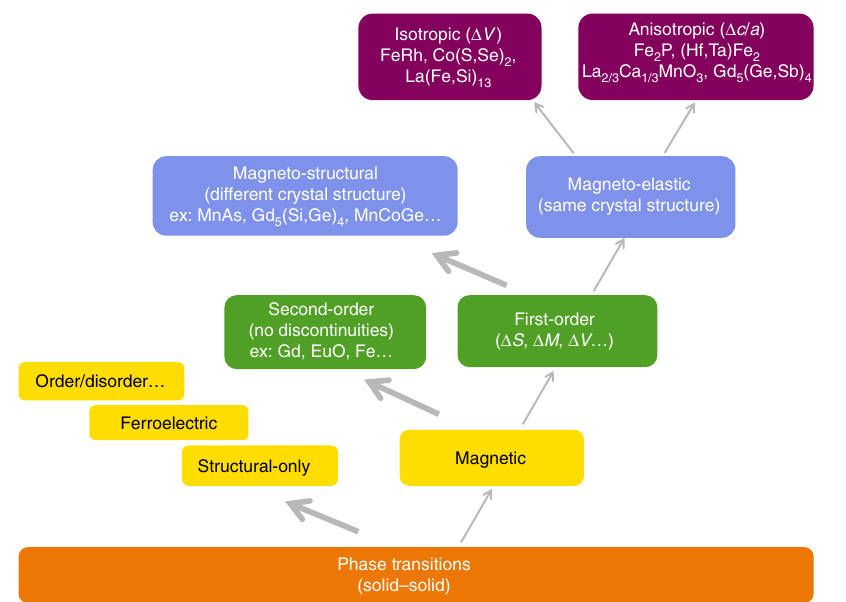
Fig. 1 A classi fi cation diagram of solid-state phase transitions. Several types of magnetic phase transitions are categorized focusing on the magnetoelasticity branch, with examples of materials families 7,9 – 14,24,38,52 – 55 . Different sub-classes are distinguished depending on the Ehrenfest classi fi cation ( fi rst/second order), whether the magnetic transition is associated with a change in crystal symmetry (magneto-structural/magneto-elastic), and depending on the nature of the lattice parameter discontinuities